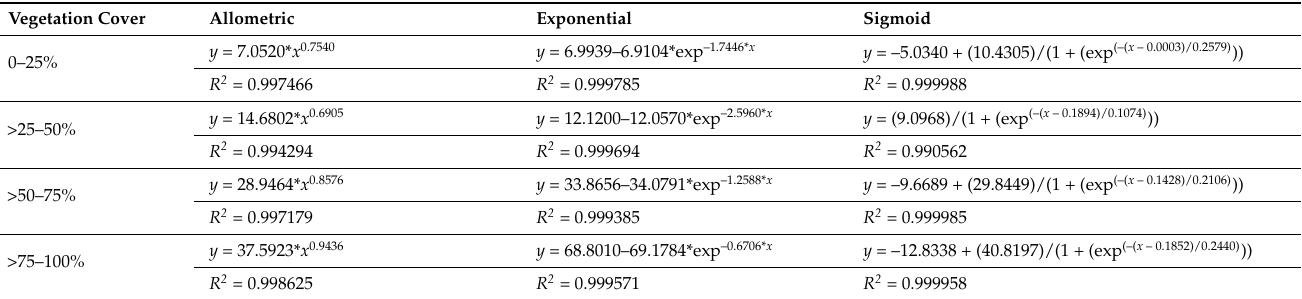
Table 4. Model parameters and fitting results of cumulative soil organic carbon (SOC) stock (kg C/m 2 ) using three functions in ten sites of sabkhas with different vegetation covers along the southern Red Sea coast of Saudi Arabia.